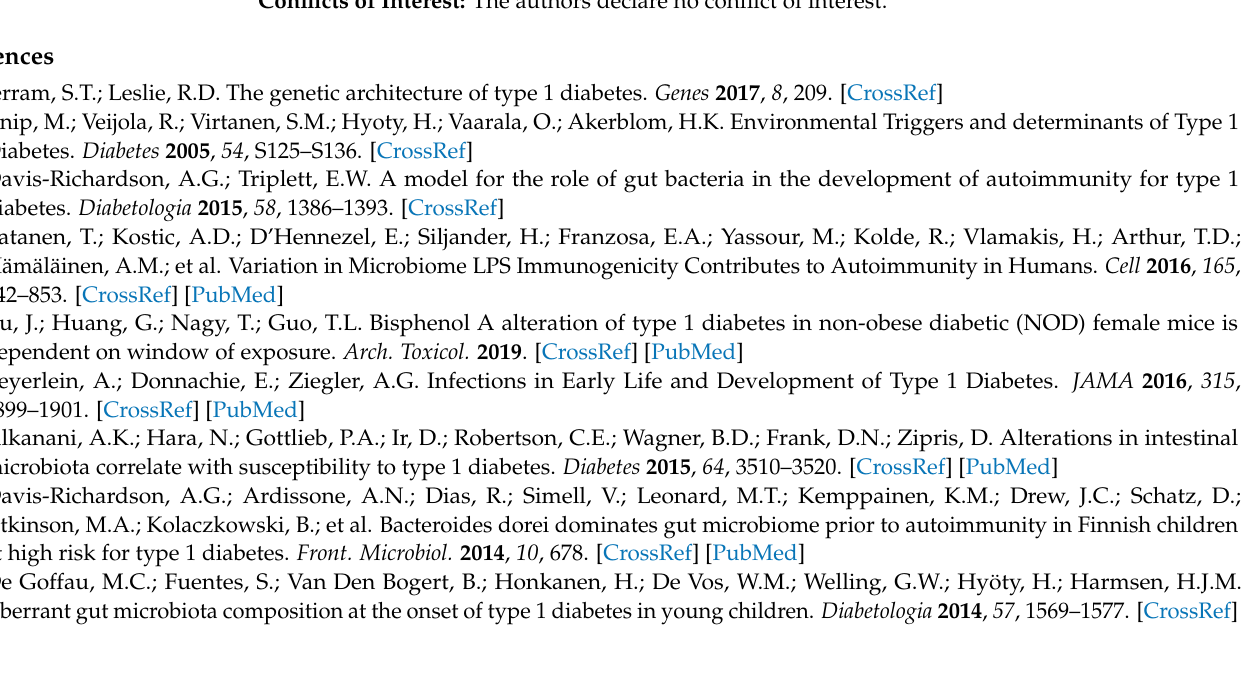
children, Figure S3: Genome map of P. dorei PtFD1P5 (a), P. dorei PtF D8M1 (b), P. dorei PtF D16M14 (c) , P. dorei PtF Sb8 (d), P. dorei PtF Sb6 (e) P.dorei PtFC1P2 (f) and B. uniformis PtFSb3P5 (g), Figure S4: Phylogenetic relationships of the whole genome sequenced strains of P. dorei , B. uniformis and P. distasonis based on 30 genes, Table S1: Primers used in qPCR, Table S2: qPCR reaction conditions used for the tested bacterial groups, Table S3: Genes selected for MLSA, Table S4: Antibiotic susceptibility, Table S5: Minimum Inhibitory Concentration of Imipinem by ε test, Table S6: Identification of resistance genes in the genomes of P. dorei , B. uniformis and P. distasonis strains using the CARD/RGI, Table S7: SEED subsystem category distribution of the genomes of P. dorei , B. uniformis , and P. distasonis strains according to RAST annotation, Table S8: Identification of prophage sequences using PHASTER, Table S9: Identification of sequences of CRISPR/Cas in the analyzed genomes using